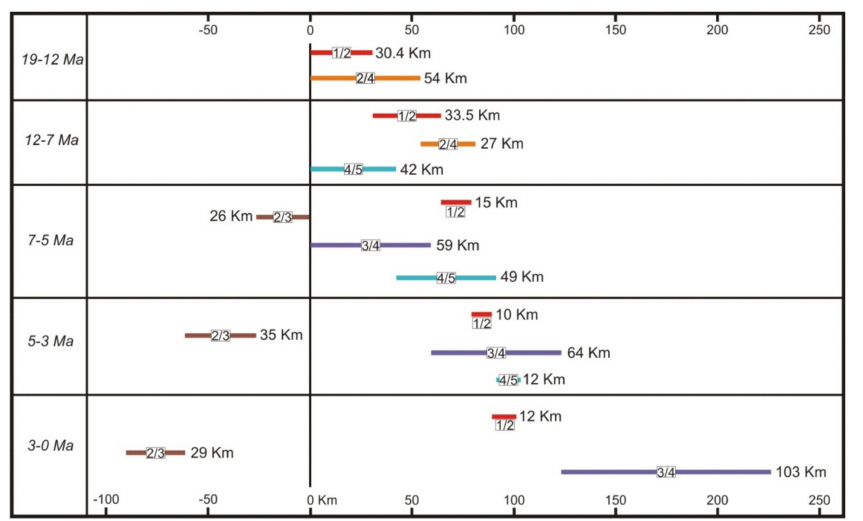
Figure 20. Estimated total shortening/extension and timing between adjacent sectors of Figure